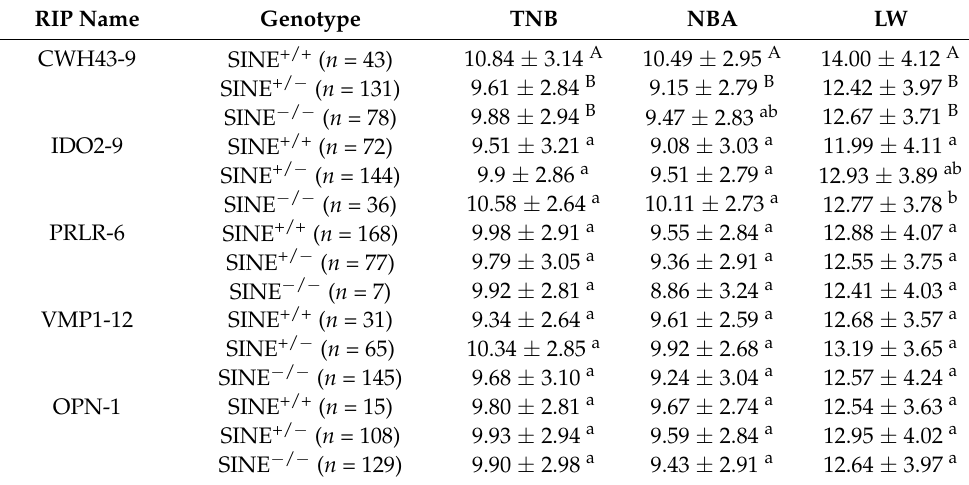
Table 4. The results of the statistical analysis for the RIPs with the reproductive characteristics of Large White pigs.